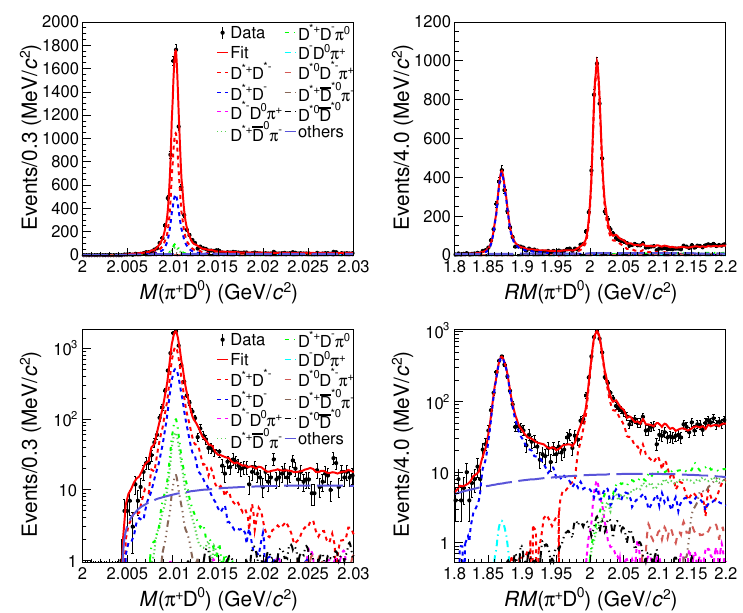
Figure 3. The 1D projections of the 2D fit (top) to the RM ( π + D 0 ) versus M ( π + D 0 ) distributions for the reconstructed D ∗ + candidates at 4.416 GeV and the corresponding log-scale plots (bottom). Dots with error bars are data. The red solid lines represent the fit result; the red and blue dashed lines denote the signal processes of e + e − → D ∗ + D ∗− and e + e − → D ∗ + D − , respectively; the other dashed lines in different colors represent different background